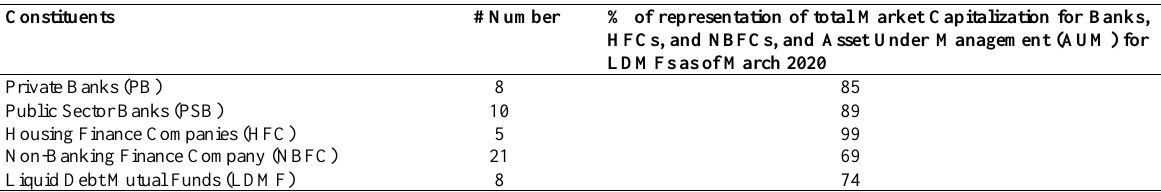
Table 1. Composition of financial institutions.